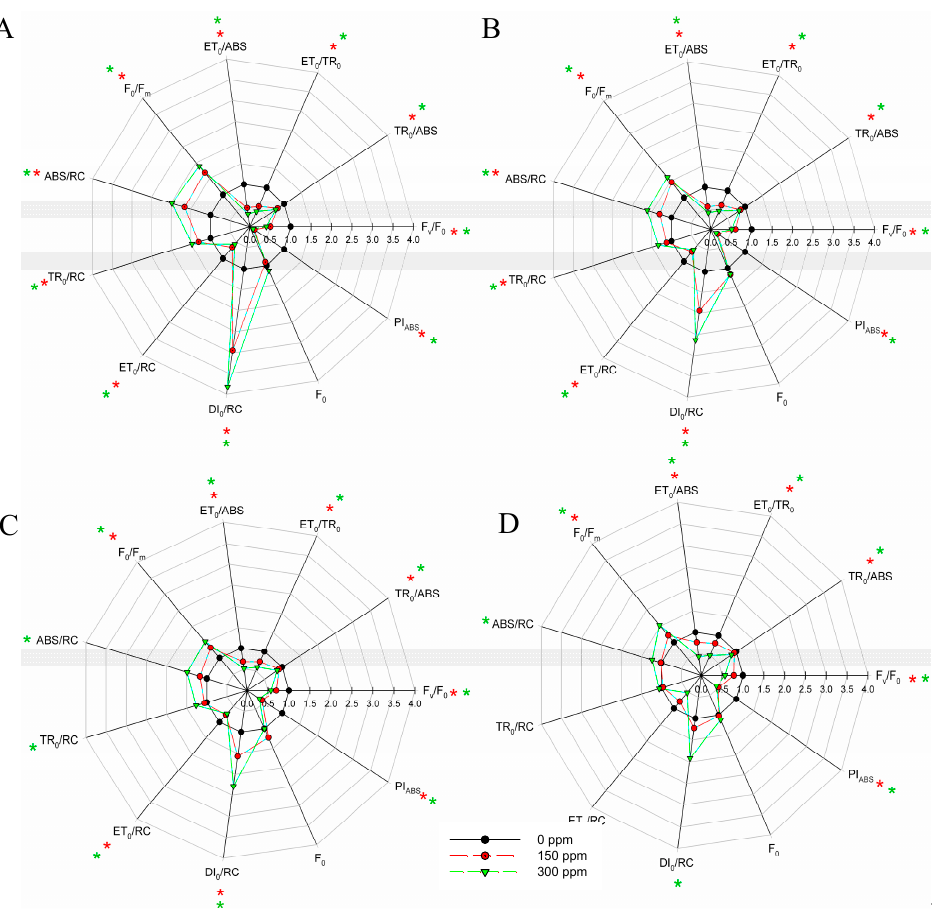
Figure 12. Changes in the shape of the radar plot JIP-test parameters induced by di ff erent copper concentrations applied to Arundo plants and measured after 7 ( A ), 14 ( B ), 21, ( C ) and 28 ( D ) days of treatment. The data are the average of eight replicates and report the values with respect to plants grown in the absence of contamination (control = 1). Red and green asterisks indicate significant di ff erences (LSD test, p ≤ 0.05) between control plants (0 ppm) and those exposed to 150 or 300 ppm copper,